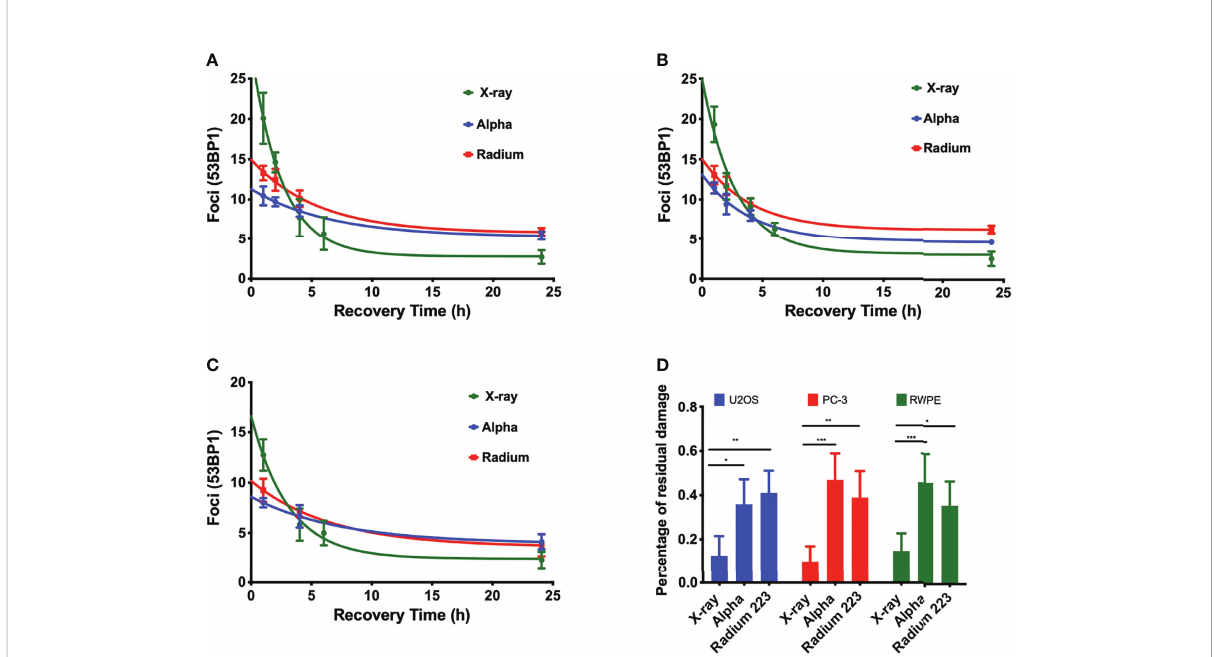
FIGURE 3 LET-dependent repair kinetics of radiation-induced foci. The repair of alpha-particle-induced foci is slower than those induced by X-rays (green) regardless of whether high LET was delivered by an external alpha source (blue) or 24-h exposure to 223 Ra (red), for (A) PC-3, (B) U2OS, and (C) RWPE. (D) Percentage of residual damage at 24 h after irradiation normalized to the initial yield of damage. Points represent the mean number of foci per cell of three independent experiments and the respective standard error. Data were corrected for the baseline mean foci